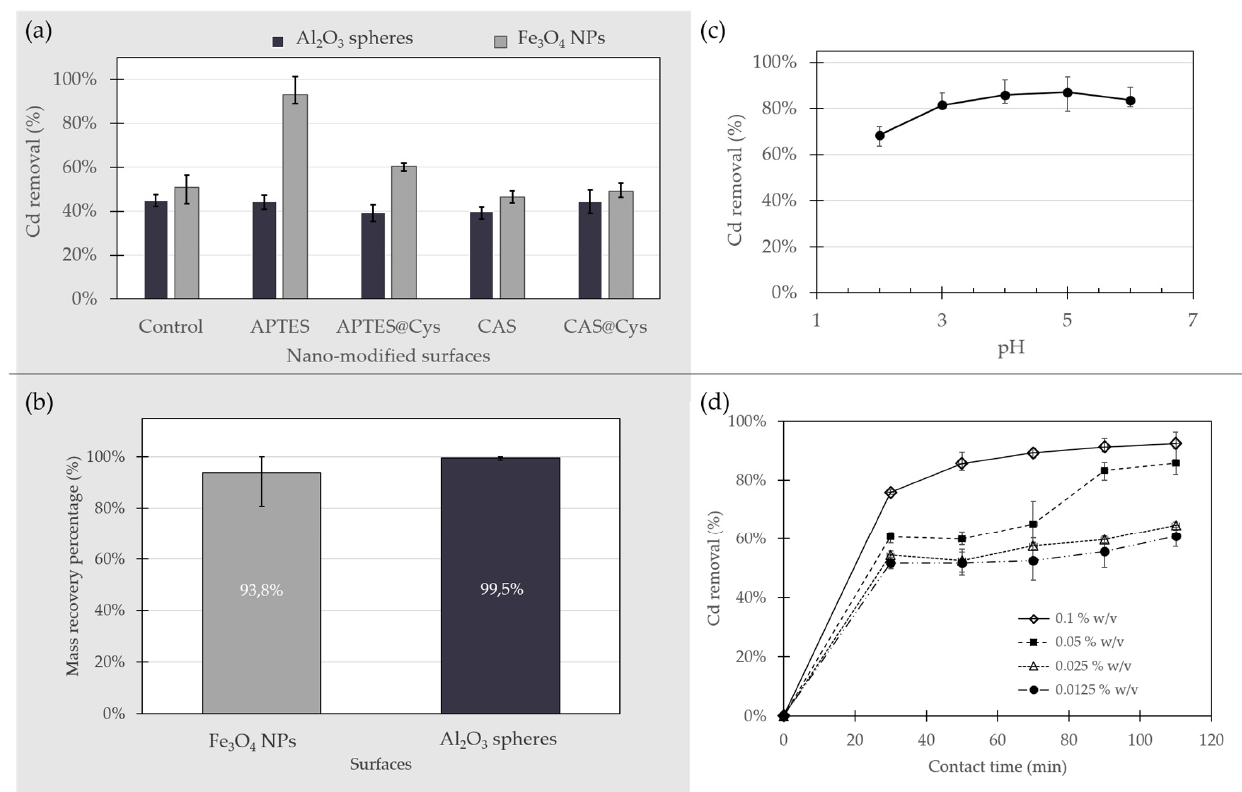
Figure 5. ( a ) Percentage of Cd removal in aqueous solution for Al 2 O 3 spheres and Fe 3 O 4 NPs. Removal efficiency (R%) was studied before and after surface modifications. ( b ) Adsorbent mass recovery after the removal assays. ( c ) Percentage of Cd removal at pH values in the range of 2.0–6.0 for Fe 3 O 4 NPs @APTES. ( d ) Removal efficiency of Cd on Fe 3 O 4 NPs @APTES as a function of contact time. Initial metal concentration of 0.1mg/L; pH 5.0 and adsorbent dose in the range of 0.0125–0.1% ( w / v ).